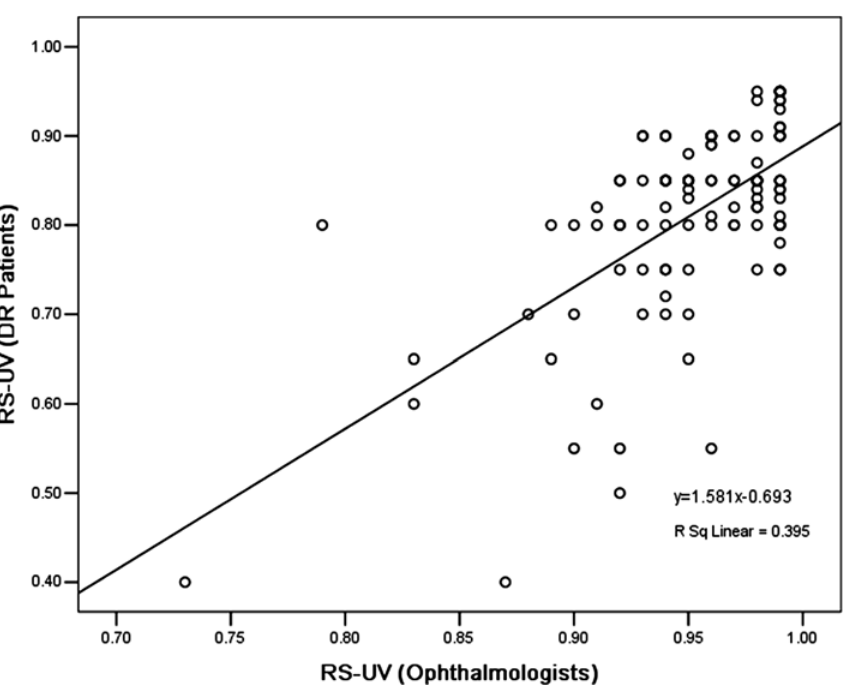
Fig 3. Scatter dot-plots of utility values from diabetic retinopathy patients and ophthalmologists, using the rating scale method.